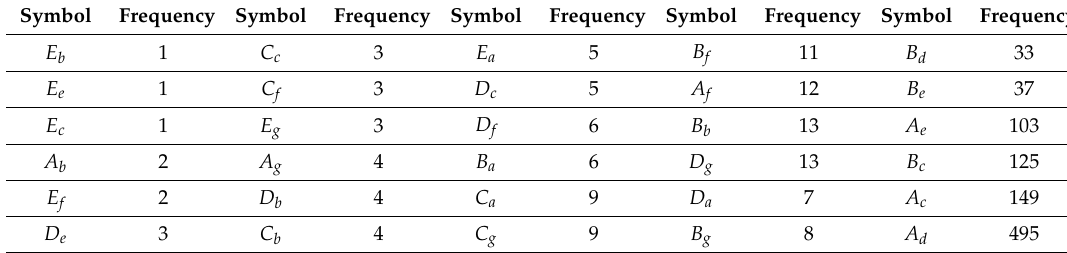
Table 3. The TFSAX representation of the daily mean water level of station